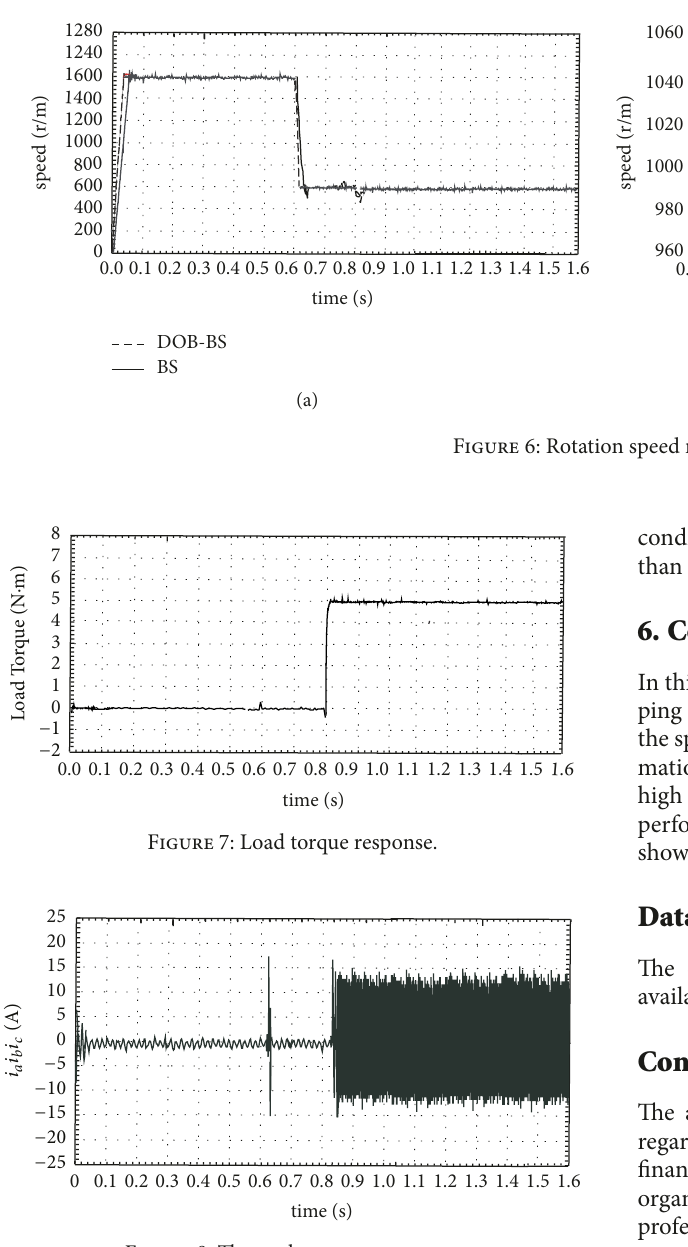
Figure 8: Three-phase stator